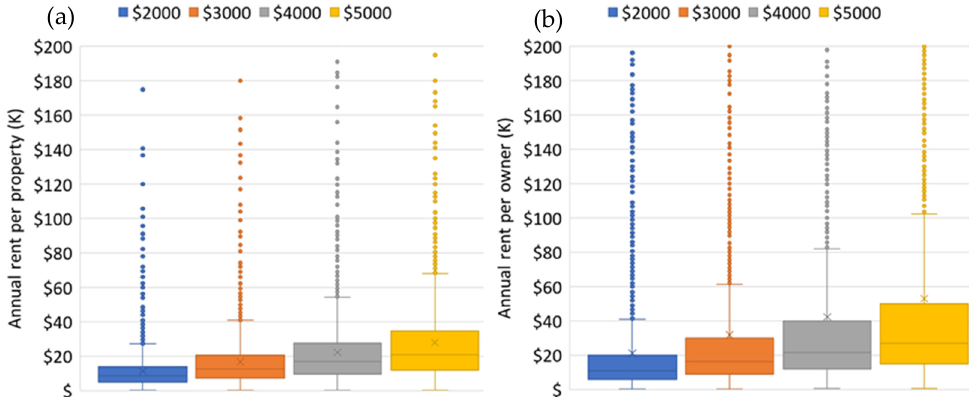
Figure 14. Box plot assessing the annual rent payments from wind turbine installed on individual lots in Texas considering diverse rental payments (USD/MW) as negotiated by proprietaries, represented by four different colors. ( a ) Annual rent payments for distinctive lots. ( b ) Annual rent payment considering different owners.